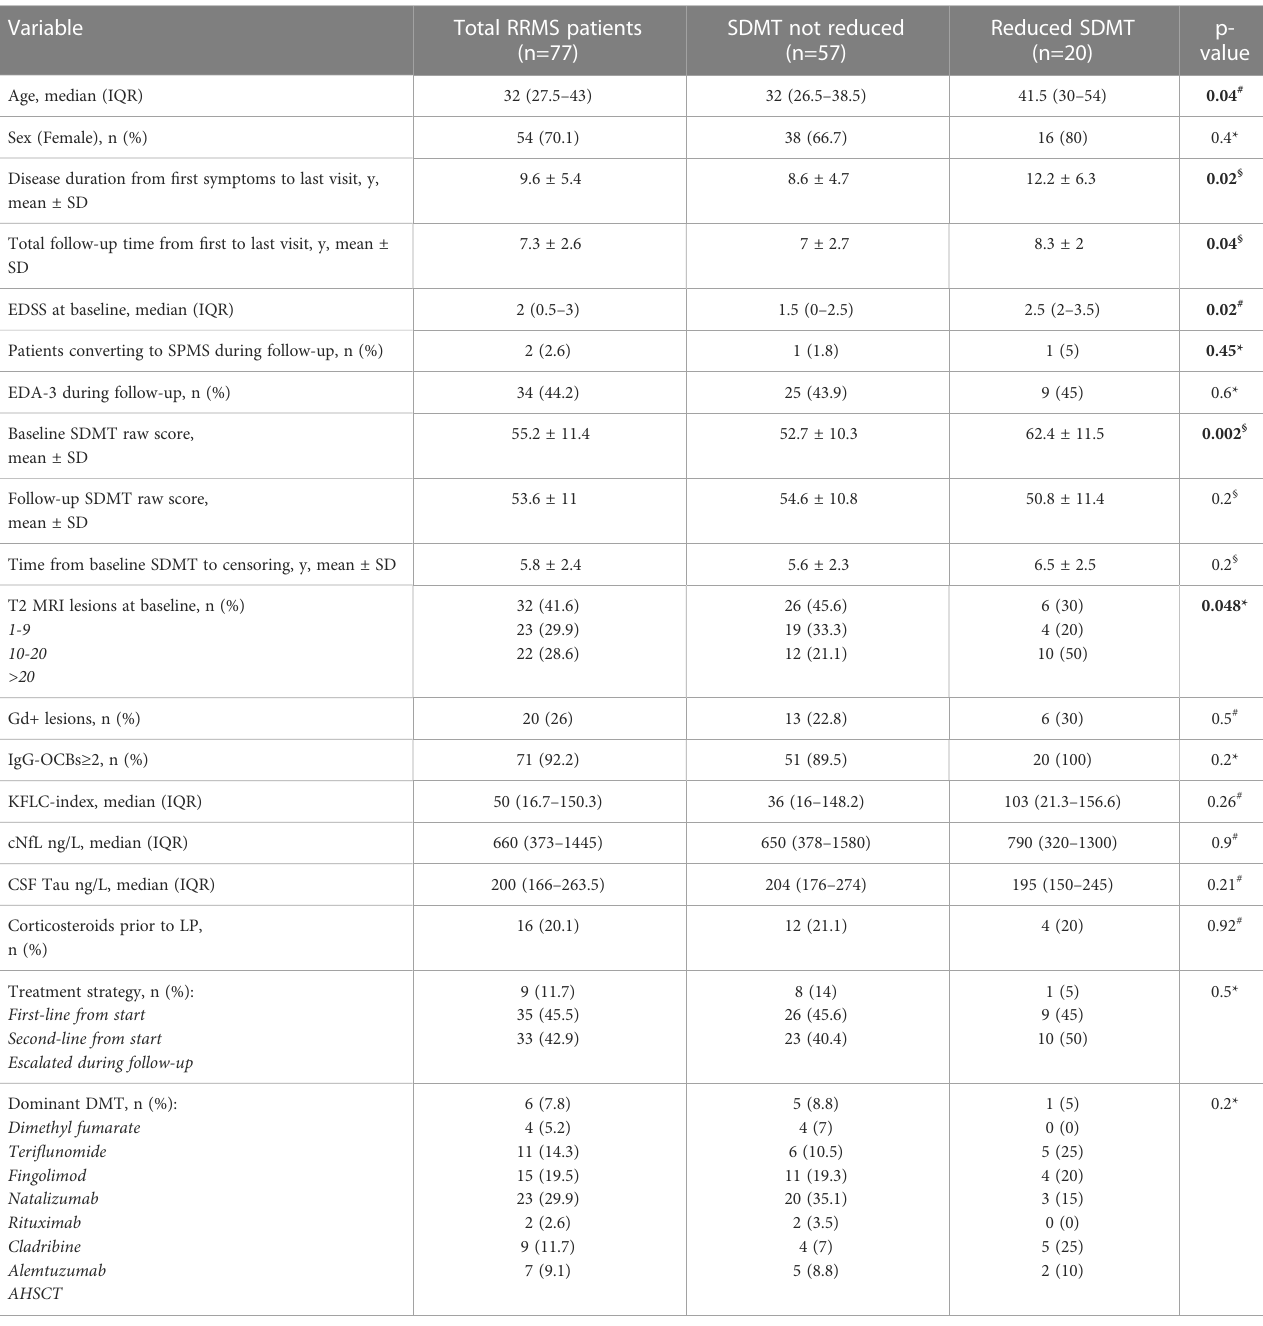
TABLE 1 Clinical and demographical characteristics of RRMS patients included in the study and dichotomized by SDMT status at follow-up.